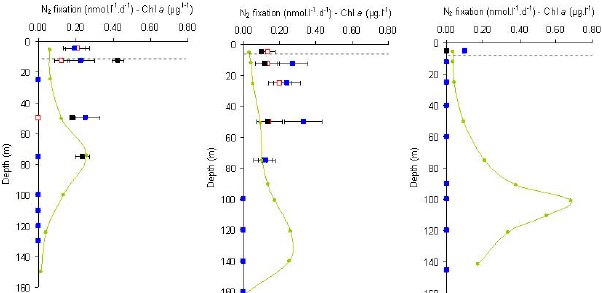
Fig. 3. Vertical profiles of N 2 fixation fluxes (nmoll − 1 d − 1 ) mea- sured at LD stations A (a) , B (b) and C (c) . Black squares: bulk N 2 fixation measured at day 1. Light blue squares: bulk N 2 fixation measured at day 3 at the same station. Red squares: N 2 fixation in the picoplanktonic ( < 3µm) fraction at day 3. Error bars represent uncertainties on the measurement. Green circle: Chl- a concentra- tions (µgl − 1 ) . Dashed line represent the mixed layer